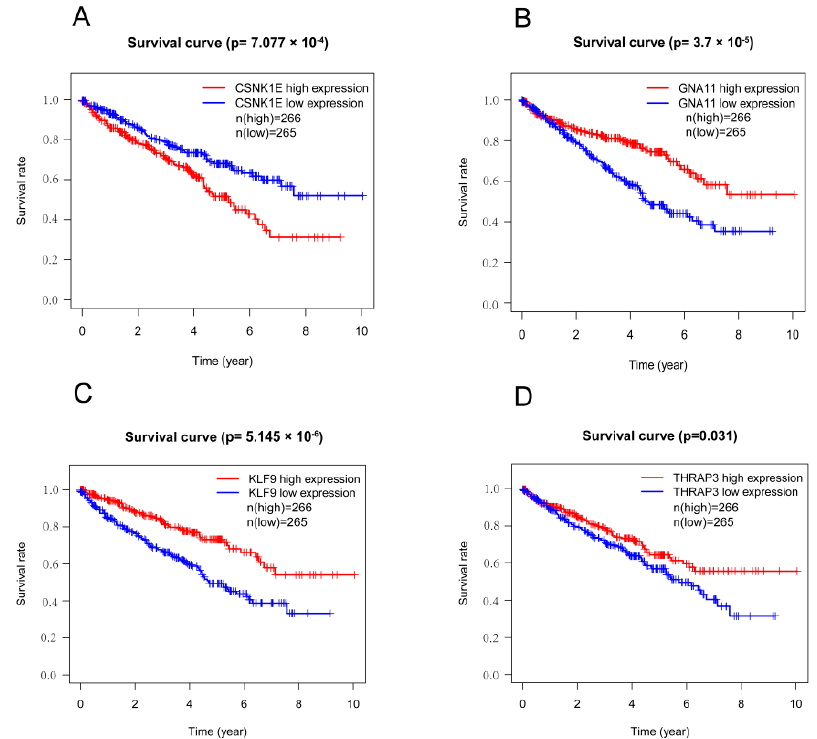
Figure 4. Survival analysis of DERGs genes enriched in the circadian rhythm process. ( A ) CSNK1E; ( B ) GNA11; ( C ) KLF9; and ( D ) THRAP3.